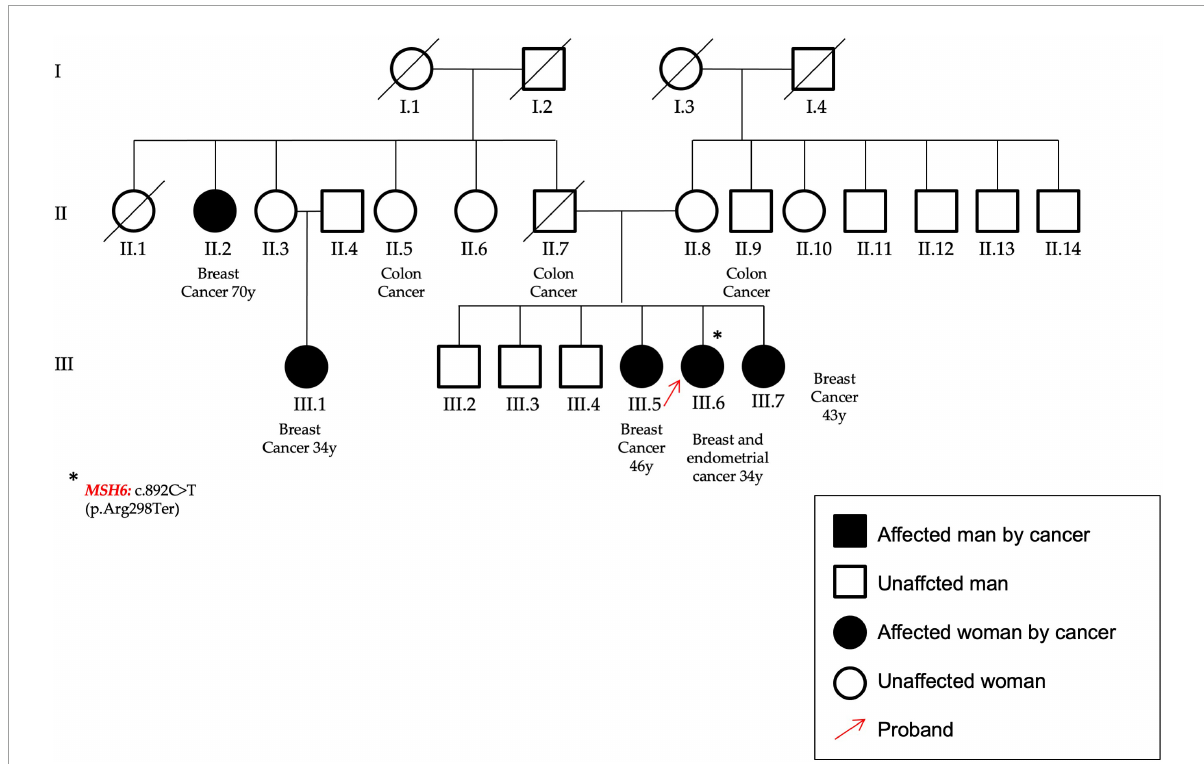
FIGURE7 In the figure the pedigree of the patient (P14) that carry the variant identified in the MSH6 gene, c.892C > T–p.(Arg298Ter). She had an early onset BC and a subsequent endometrial cancer; moreover, other cases of both breast and colon cancers are reported within her family. The proband was highlighted by a red arrow and the asterisk identifies the MSH6 gene